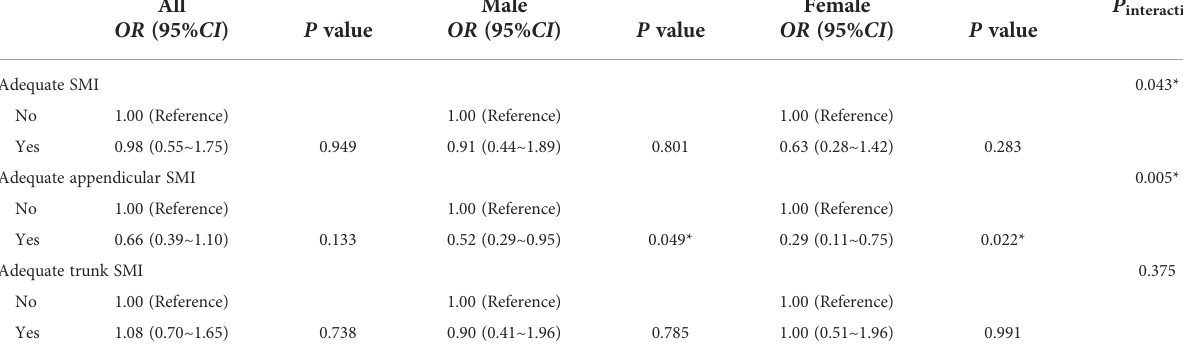
TABLE 3 Sensitivity analysis: Associations between adequate muscle mass status and MAFLD a by